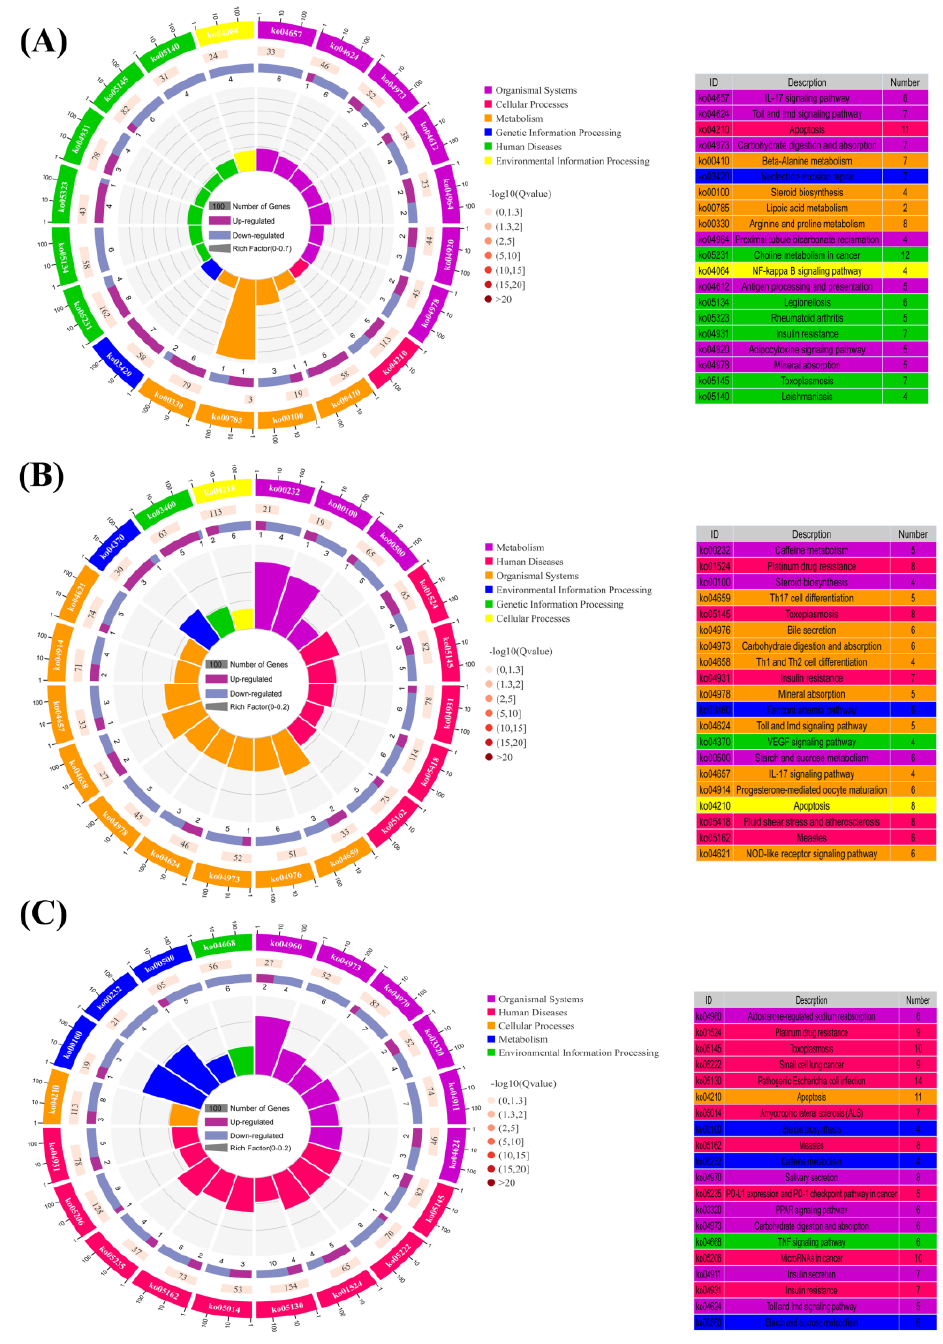
Figure 6. Top 20 pathways for KEGG enrichment analysis. ( A ) FM group vs. CPC15 group; ( B ) FM group vs. CPC30 group; and ( C ) FM group vs. CPC45 group. The first circle indicates the top 20 pathways enriched from outside to inside, with a coordinated scale of gene numbers outside, and the number and color of the number on the first circle are the same as the number and color of the number on the right side of the chart. The second circle indicates the number of genes in the background and the p -value of each pathway. The more genes, the longer the bar. The smaller the p -value, the darker the color. The third circle indicates the ratio of up-regulated genes (dark purple) to down-regulated genes (light purple), with the numbers inside the bar. The fourth circle indicates the enrichment factor (the proportion of DEGs in the background genes) for each pathway. Each cell of the background auxiliary line represents 0.1. The different colors of the first and fourth circles represent different pathway classifications.